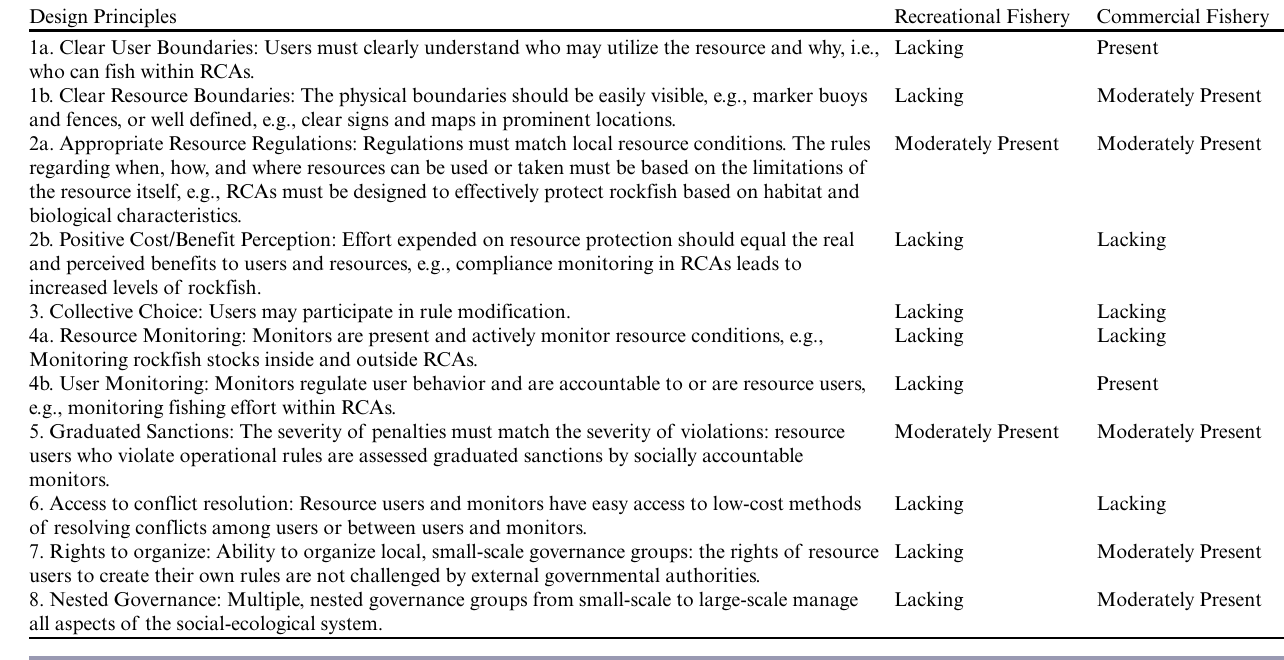
Table 6 . Analysis of relative presence or absence of the design principles in the structure of British Columbia’s network of Rockfish Conservation Areas